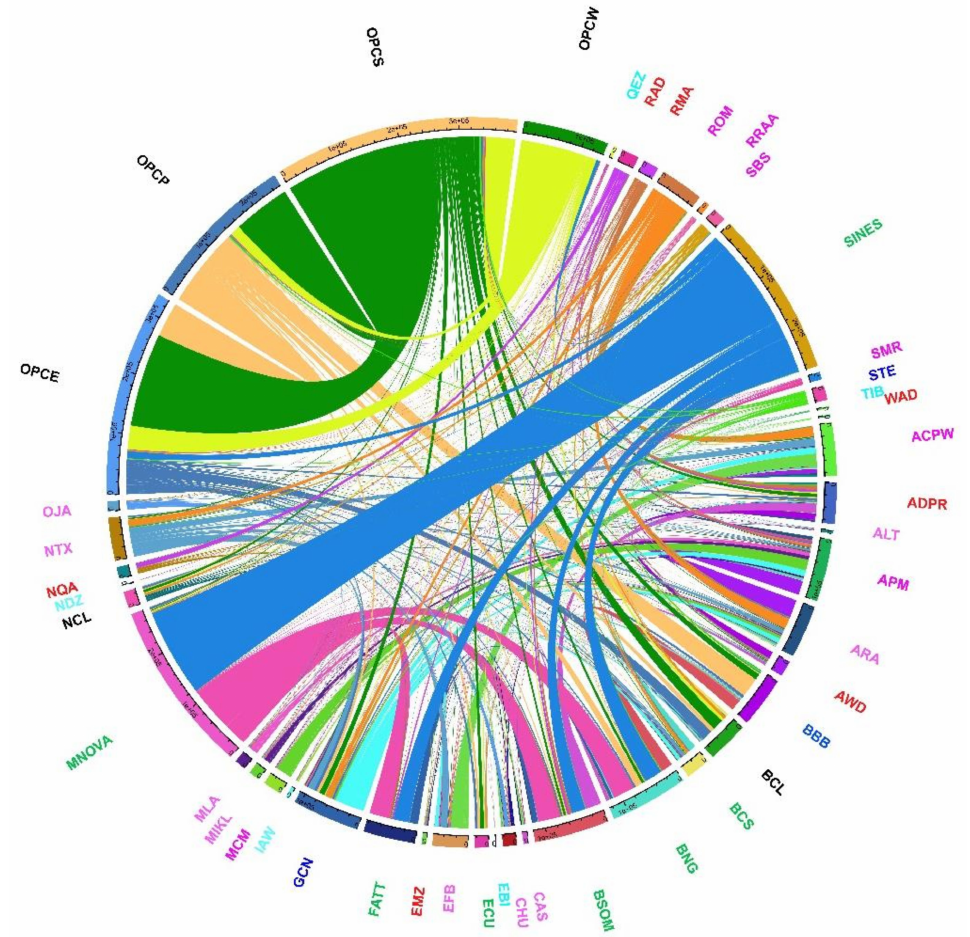
Figure 6. Circos plot of the number of haplotypes shared between breeds. Each coloured band. each coloured band represents the total number of haplotypes that are divided between a pair of races, where a greater thickness of the band represents a greater number of haplotypes. The flows within the same populations and those where the count is less than 50 are excluded from the graph. In bold are the Colombian sheep breeds. Origin of breeds are indicated by colours: light blue, Asian, Middle-East including Egypt; red, Africa; green, South-American native; blue, Caribbean; violet, European including